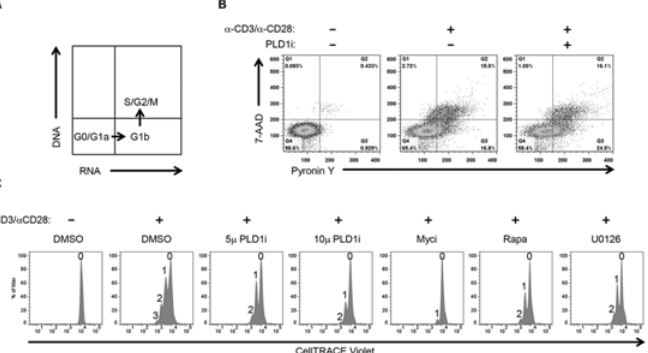
of inhibitors. The number of cellular divisions present in treated cultures is indicated above each